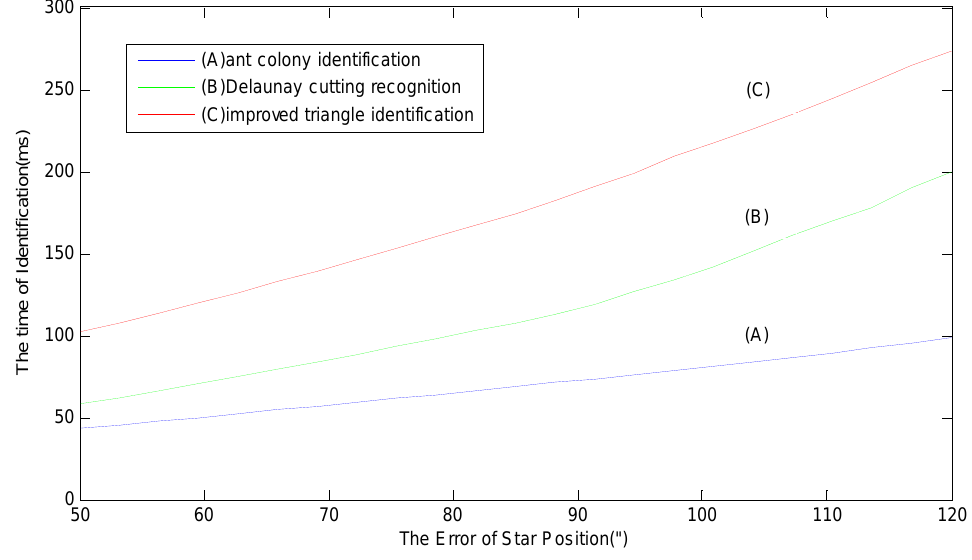
Figure 5. Relationship graph of position error and the time of